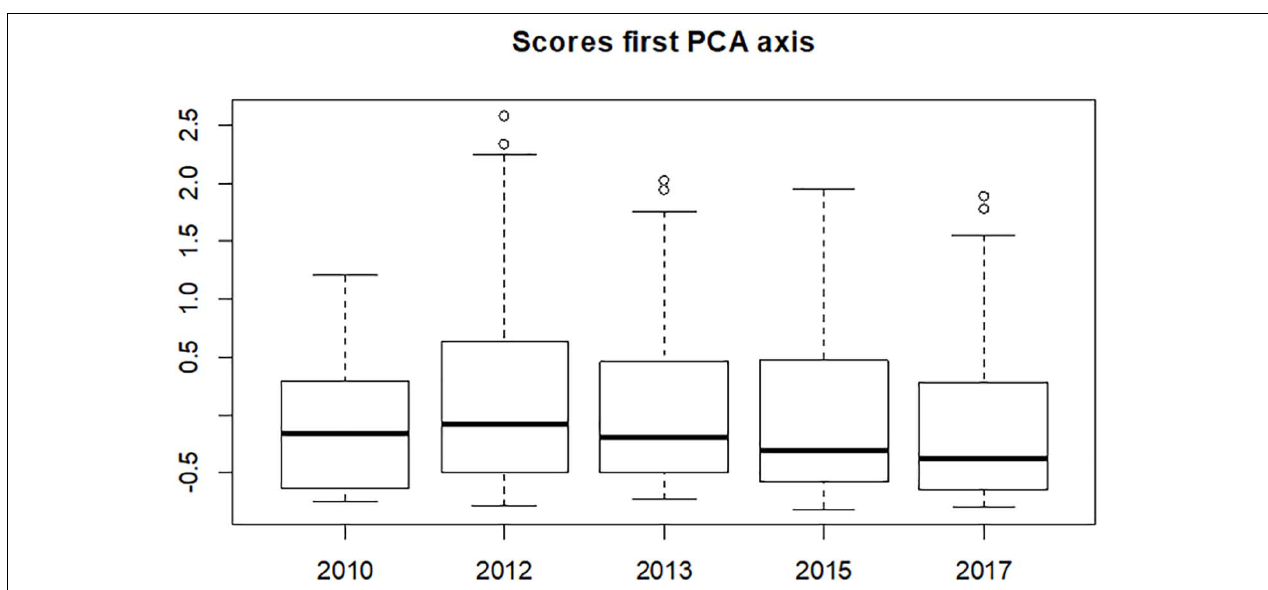
The maps of bottom shear stress and especially of median grain size show that the environmental influence of the Sand Motor goes well beyond the constructed peninsula itself, even when its immediate offshore zone is included. Increased bottom shear stress is found to a considerable distance offshore of the